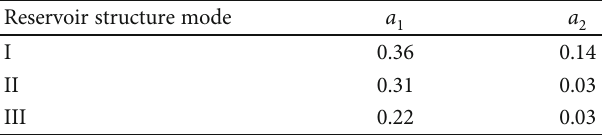
. (a) The correlation of the k , b , b of Equation (8) in Akpo oil fi 1 2 3